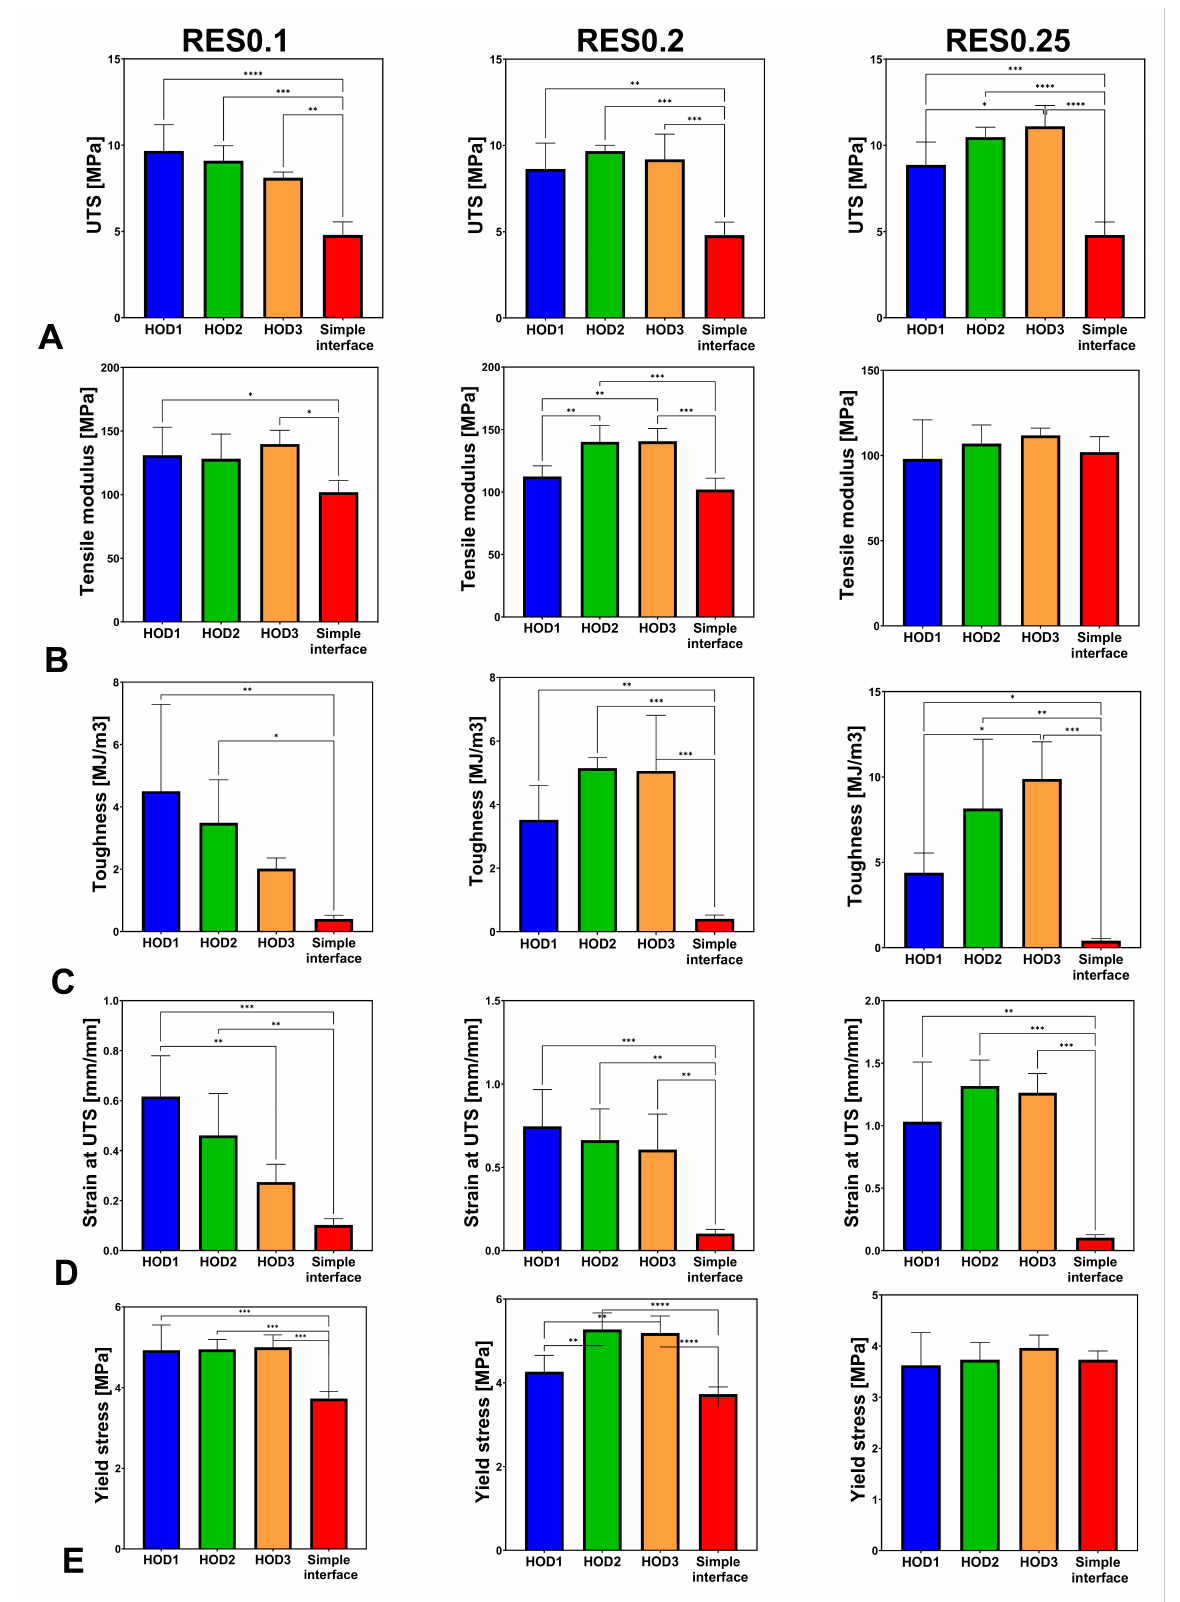
Figure 8. Effect of the horizontal distance (HOD) on the mechanical properties of stiff-to-compliant samples: ( A ) UTS; ( B ) tensile modulus; ( C ) tensile toughness; ( D ) strain at UTS; ( E ) yield stress (* stands for p < 0.05, ** for p < 0.005, *** p < 0.0005, and **** p <